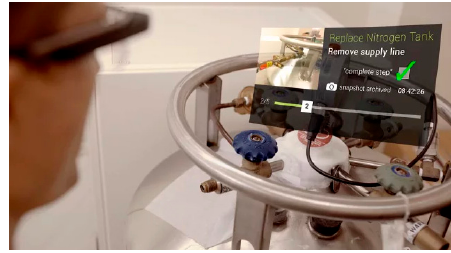
Figure 22. Maintenance with AR.